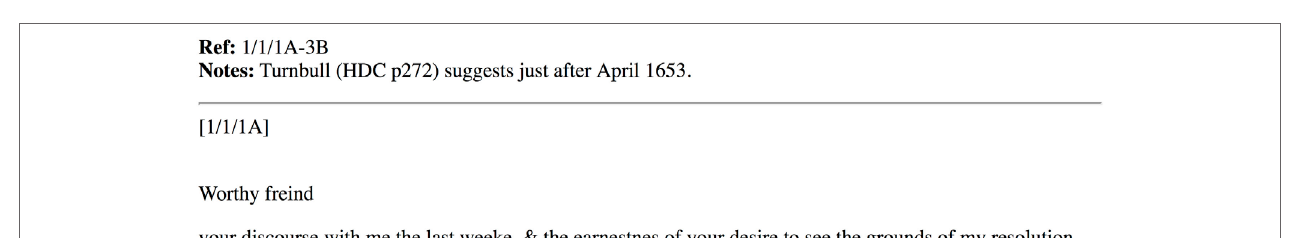
FigUre 1 | TEI XML sample taken from the Hamilton Letters.